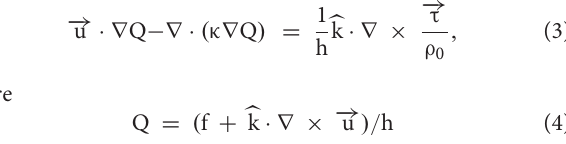
PV distribution and upper-ocean circulation in the